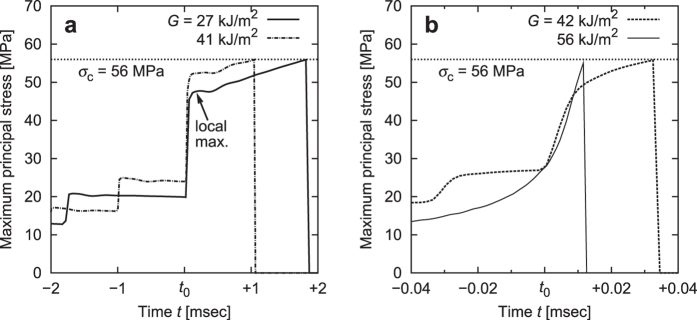
Maximum principal stress on an element on the crack path as a function of time.(a) Slow mode (G = 27 and 41 kJ/m2). (b) Fast mode (G = 42 and 56 kJ/m2). The element faces the carck tip at time t = t0. Note that the magnitude of absissae in figures are different by about 2 orders.